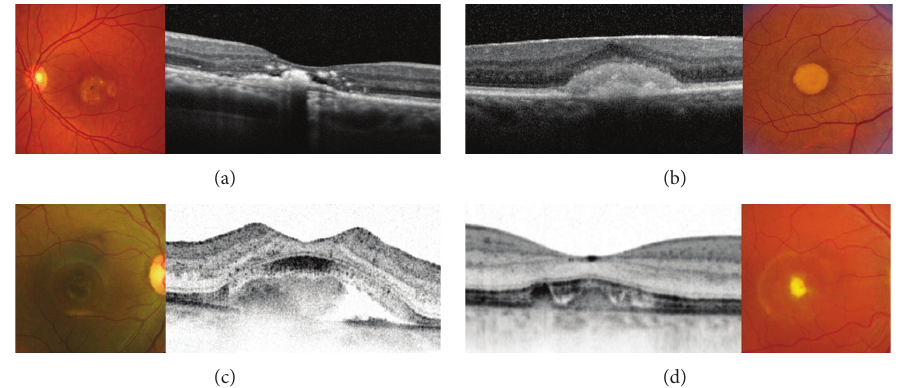
Figure 4: Spectral domain-OCT scans document the natural evolution of BVMD. Firstly a thicker layer between the photoreceptors inner/outer segment interface and the underlying RPE (previtelliform stage). The material is subsequently deposited under the neurosensory retina (vitelliform stage) and is sometimes accompanied with a neurosensory detachment (pseudohypopyon stage) secondary to its reabsorption, with abnormalities of the RPE and subsequent thinning of all retinal layers (vitelliruptive and atrophic